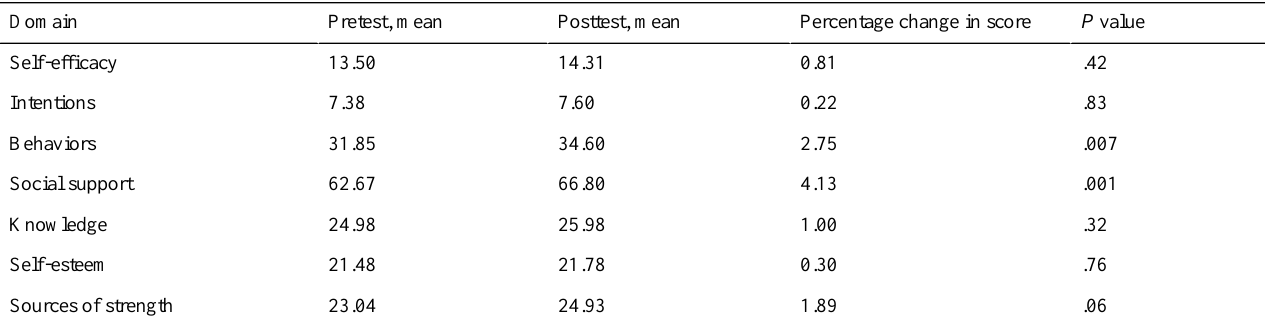
Table 3. Changes in domain scores between baseline and postintervention surveys.